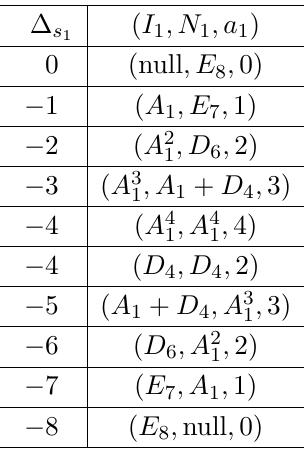
Table 2 . Invariant and normal lattices obtained from moving A 1 ’s in E 8